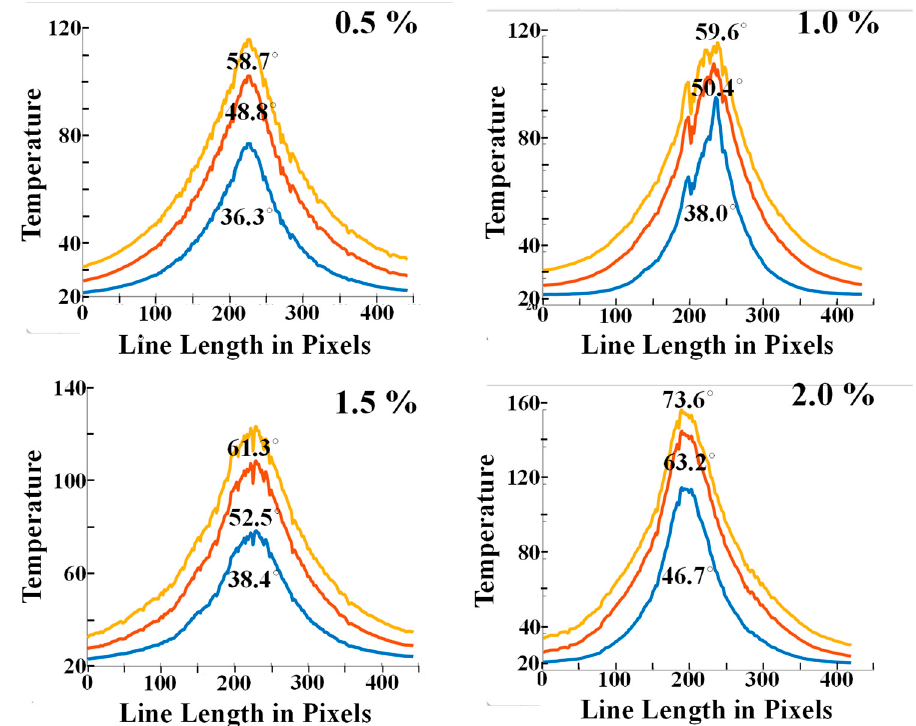
Figure 8. The temperature distribution pattern of along the line representing the highest temperature zone. The number in each curve represents the average temperature of the area covered by it.